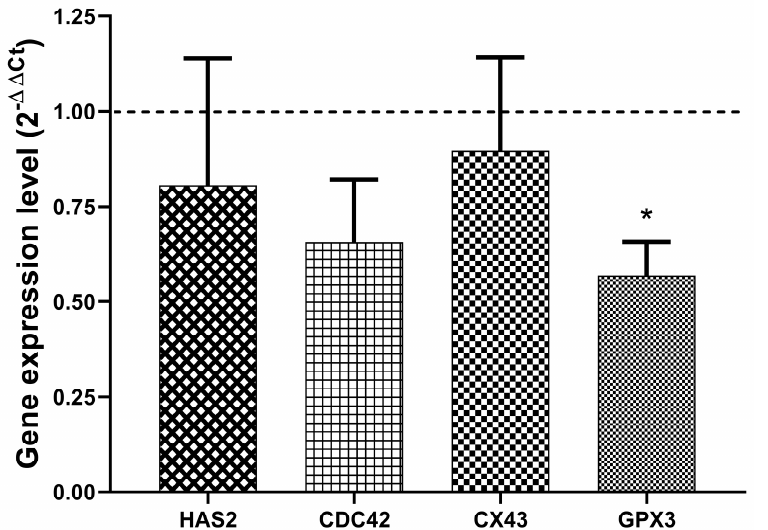
Figure 1. Expression of genes involved in the development of oocytes in cumulus cells. Relative expression of HAS2, CDC42, CX43, and GPX3 in cumulus cells retrieved from follicles of the pregnant group ( n = 17) compared to the non-pregnant group ( n = 55; dashed line). Data represent the mean ± SEM. * p < 0.001 compared to the non-pregnant group.